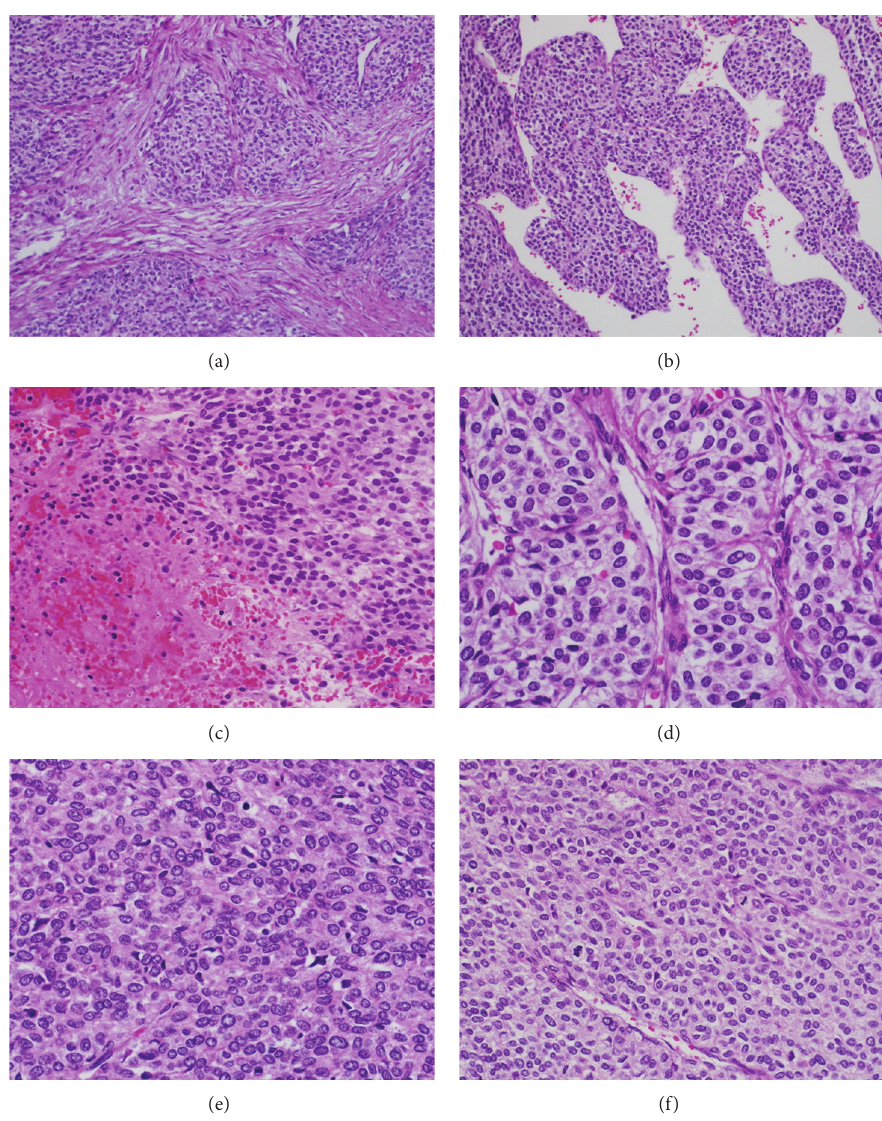
Figure 2: Histopathology of the excised intestinal ileum tumor. (a) Low power view showing multinodular growth. (b) Branching vascular channels lined by endothelial cells and interspersed by uniformly round to ovoid glomus cells forming nest, sheets, and trabeculae. (c) Area of geographic tumor cell necrosis. (d) Hypercellularity with distinct cell borders. (e) Areas of hypercellularity with mild atypia. (f) Focal spindled cells with scattered